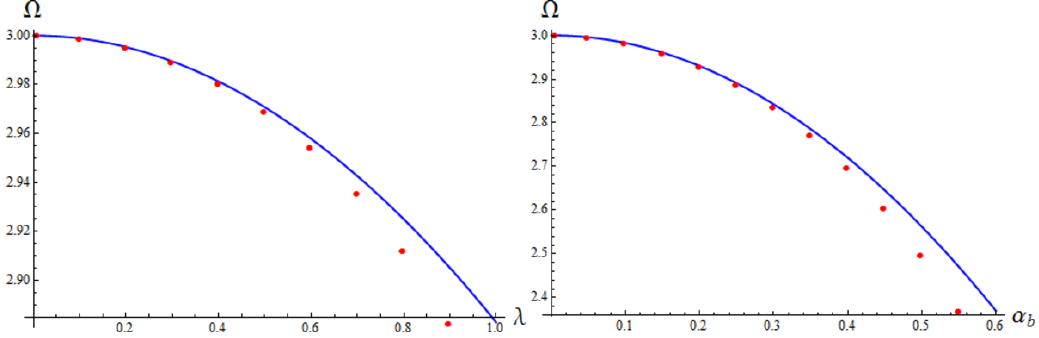
Figure 6 . Left: (cid:10)(0 : 0005 ; (cid:21) ) as determined numerically (red dots) and perturbatively (blue line). Right: (cid:10)( (cid:11) b ; 0 : 001) as determined numerically (red dots) and perturbatively (blue line).